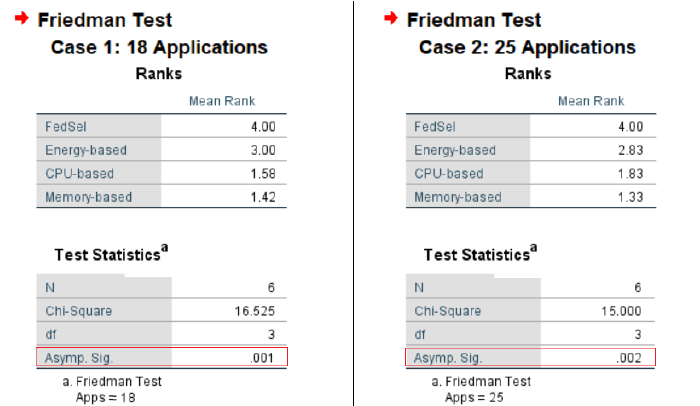
Figure 4. Friedman rank test results.